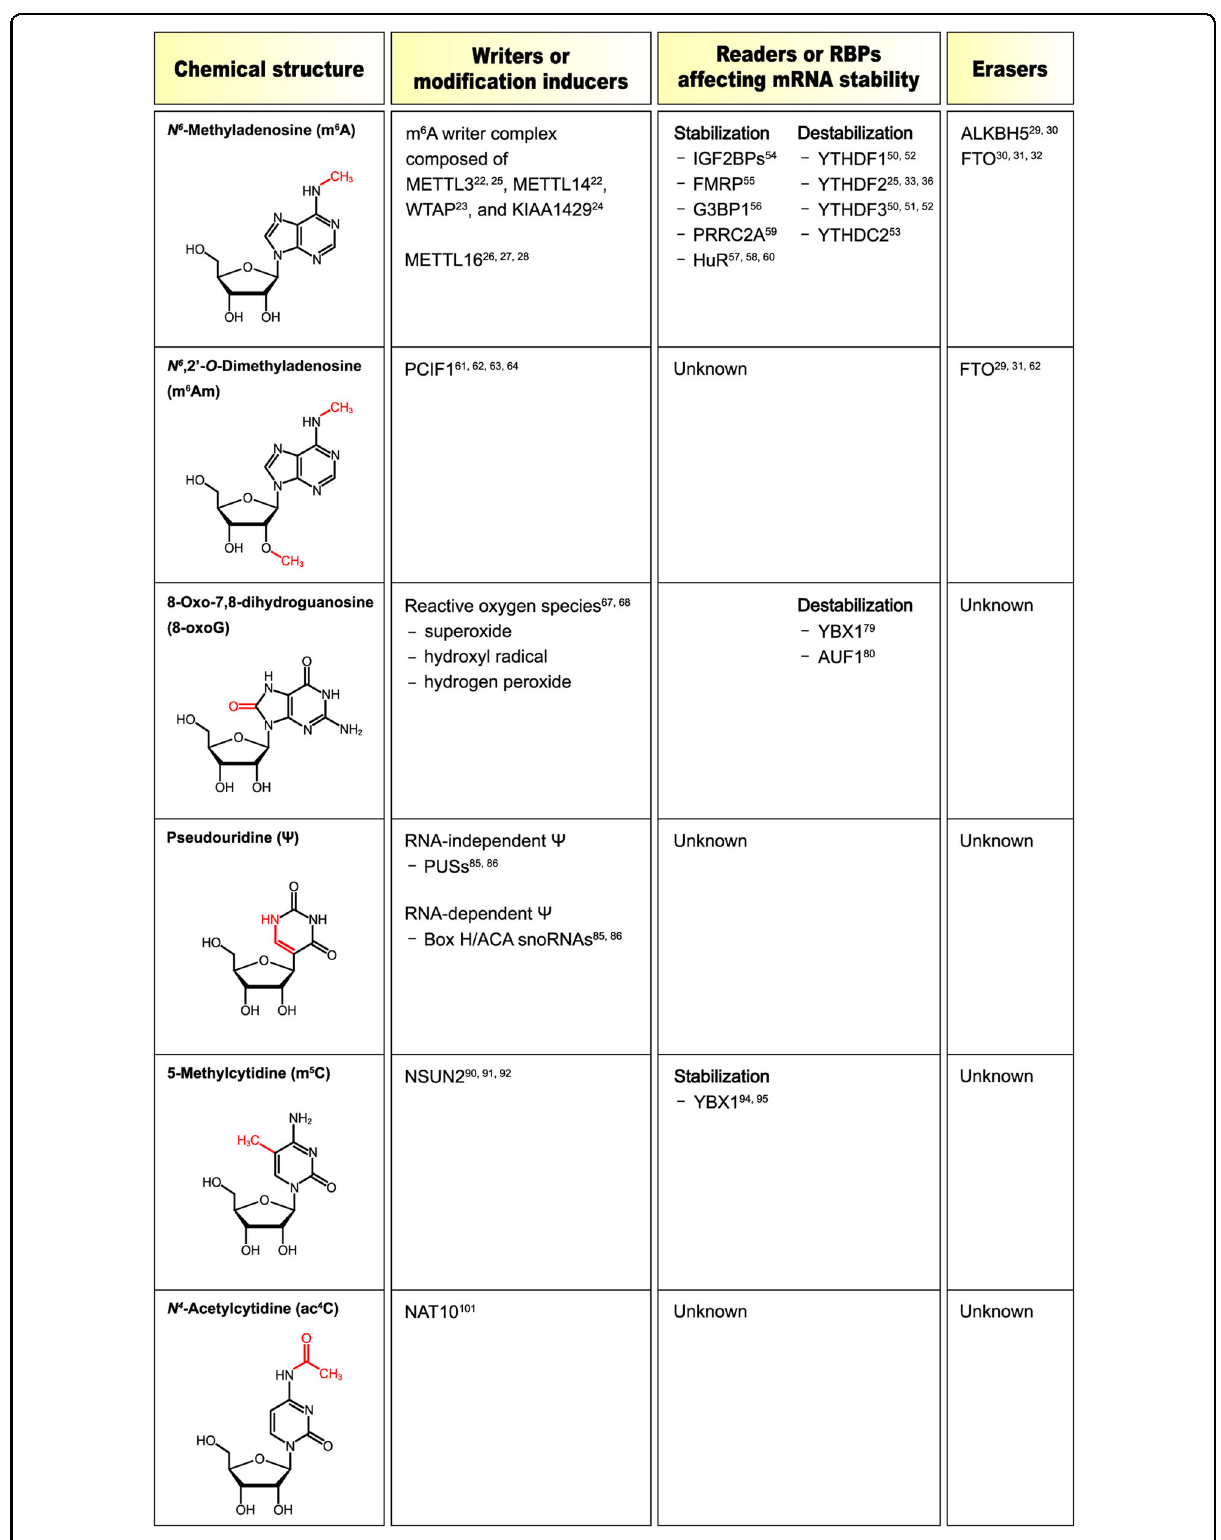
Fig. 1 Chemical structures of RNA modi fi cations affecting mRNA stability. The chemical structures of the six RNA modi fi cations discussed in this review are shown. The modi fi ed chemical groups are depicted in red. The known writers (or modi fi cation inducers), readers (or RBPs) involved in mRNA stability, and erasers for each RNA modi fi cation are also